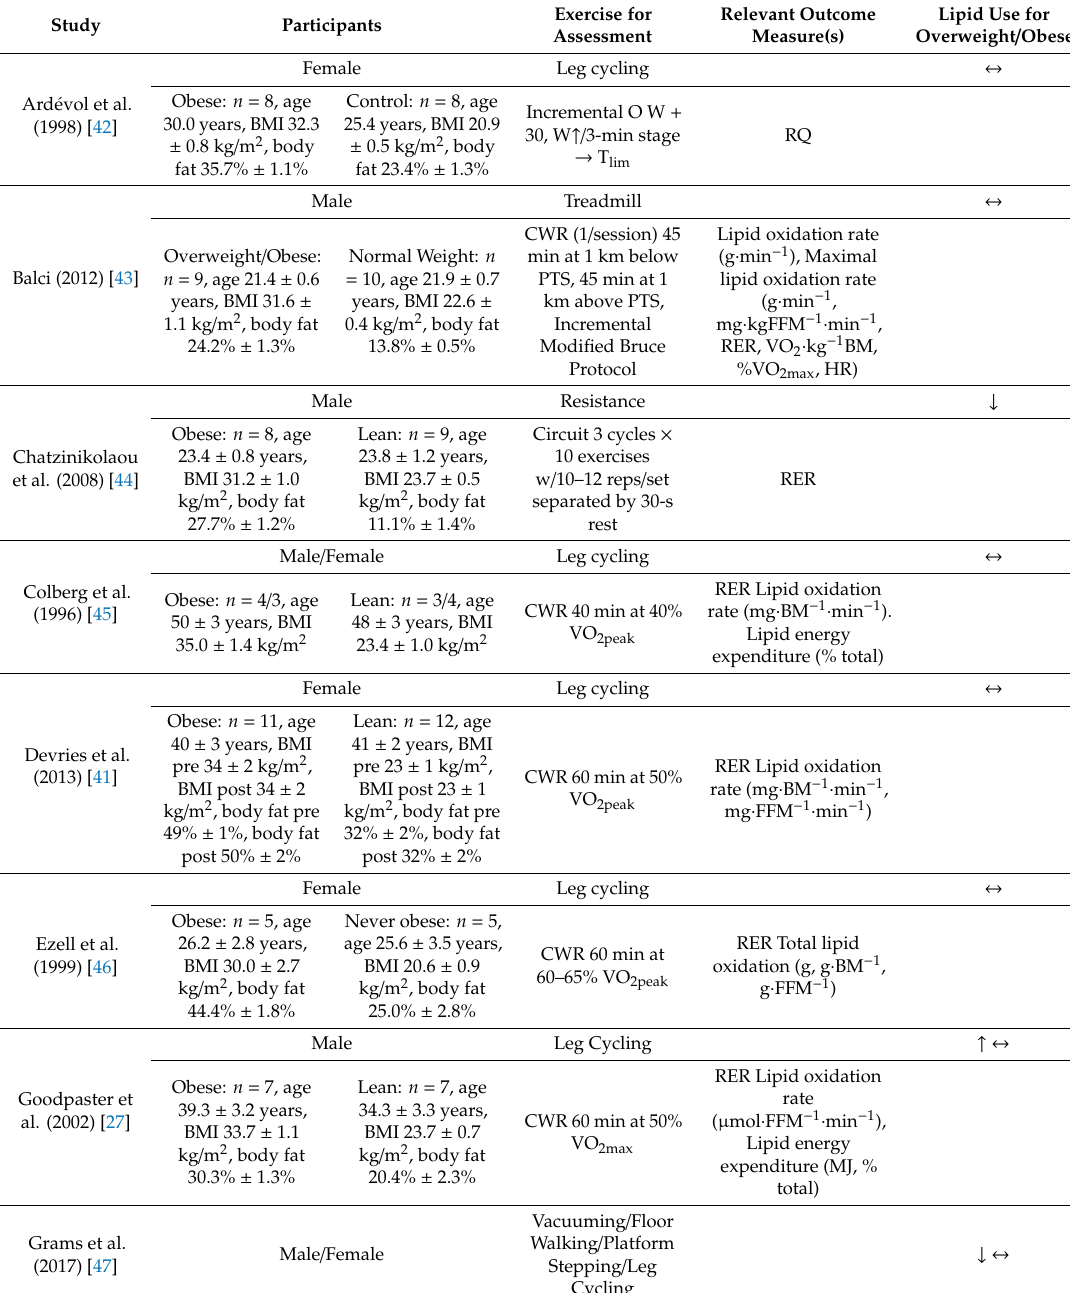
Table 1. Characteristics of the participants assessed, criterion exercise bout(s) used to determine fuel use, conclusions, and outcome measure(s) cited for the 24 included